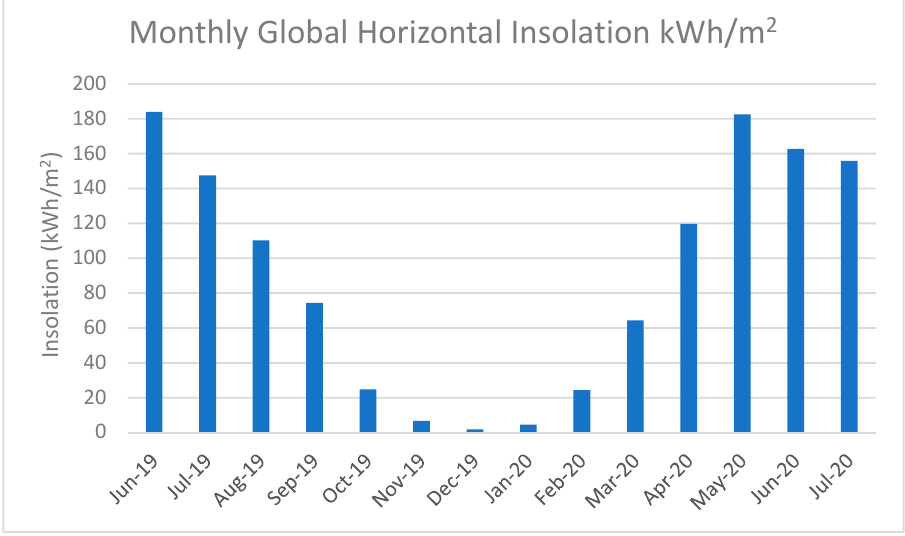
Figure 2. Global horizontal insolation for the time period discussed in this paper as measured by a Hukseflux SR-30 pyranometer at the site.